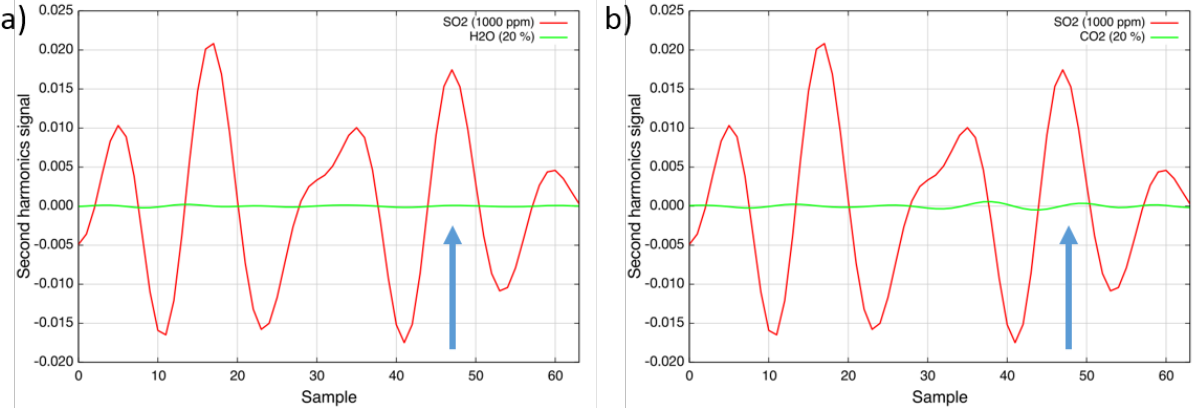
Figure 4. ( a ) Second harmonic spectra of 1000 ppm sulfur dioxide (red) and 20% water vapor (green) at 160 °C; ( b ) Second harmonic spectra of 1000 ppm sulfur dioxide (red) and 20% carbon dioxide (green) at 160